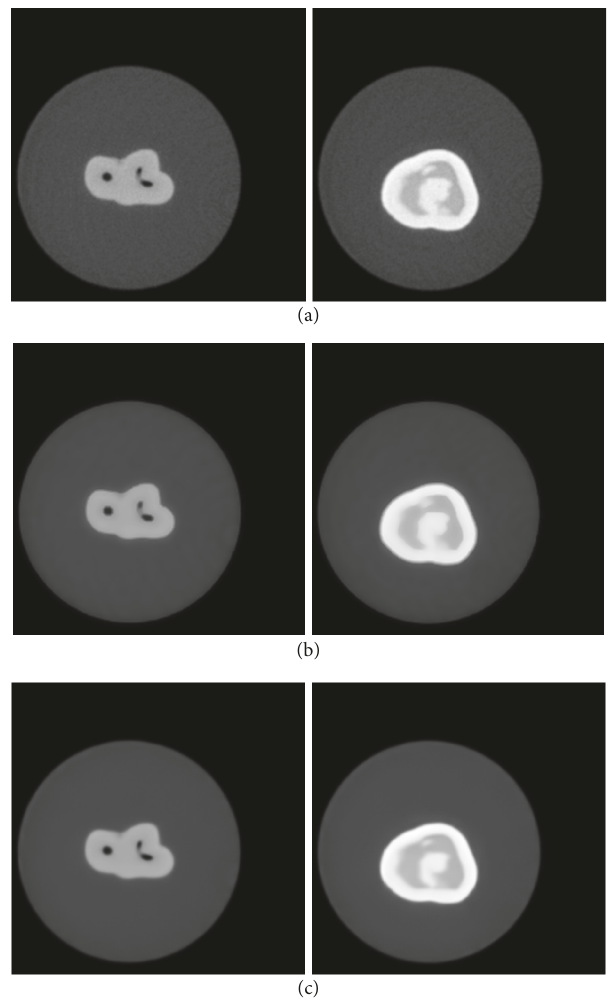
Figure 2: Preprocessing results of tooth dataset. From top to bottom: original slice data, denoised images by the nonlinear enhancement algorithm, and denoised images by MLP. (a) Original slice data; (b) nonlinear enhancement denoised result; (c) MLP denoised